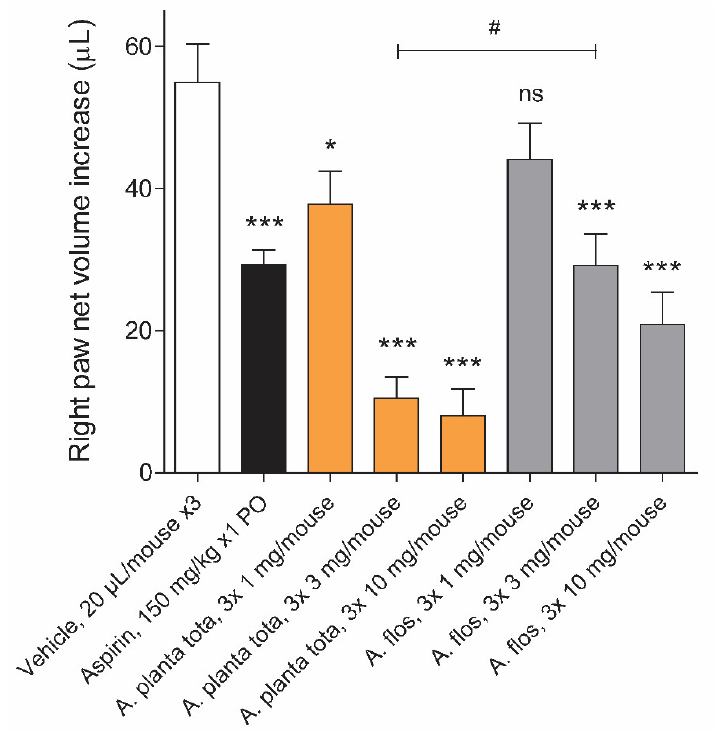
Figure 6. Inhibition of carrageenan-induced paw oedema in mice treated with Arnicae planta tota or Arnicae flos ( n = 6). The indicated amounts of Arnicae planta tota and Arnicae flos were applied topically to the right hind paw of male ICR mice three times at 20 min intervals before intraplantar carrageenan injection. The positive control aspirin was given orally (PO) 1 h before carrageenan injection. Right hind paw oedema was recorded 4 h after carrageenan injection. Uninjected left hind paw served as internal negative control. Data are expressed as right-hind-paw net volume increase (µL) and represent mean ± SD paw volume increase of six mice treated in parallel (one representative experiment out of two independent experiments). Differences in paw swelling in treated conditions vs. vehicle control were tested using a one-way ANOVA followed by Dunne’s multiple comparison test (*, p < 0.05; ***, p < 0.001). A further comparison of swelling at the respective concentrations of Arnicae planta tota vs. Arnicae flos showed a significantly reduced swelling at 3 × 3 mg/mouse Arnicae planta tota vs. Arnicae flos (#, p < 0.05). Abbreviations: A. planta tota, Arnicae planta tota; A. flos, Arnicae flos; ns, statistically non-significant.